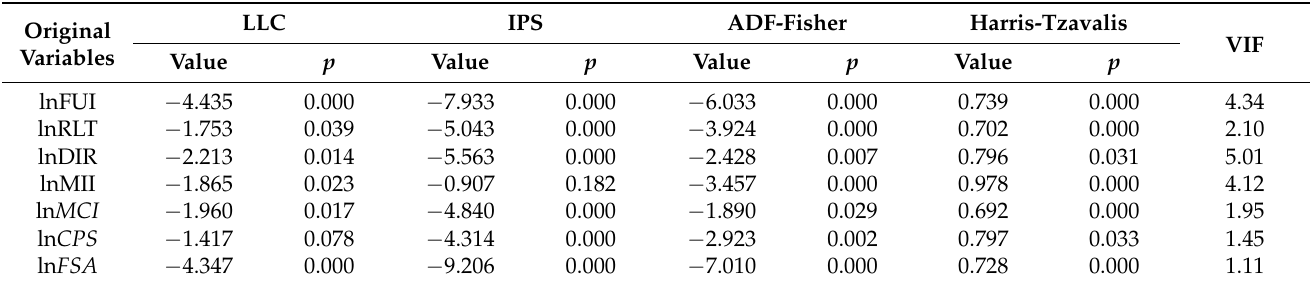
Table 3. Unit root test results of variables.